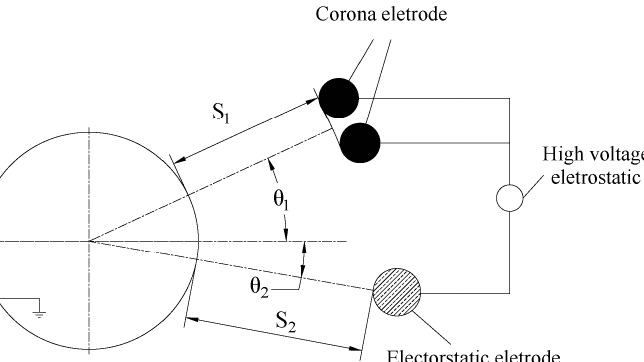
Figure 3. Schematic diagram of the electrode positions.